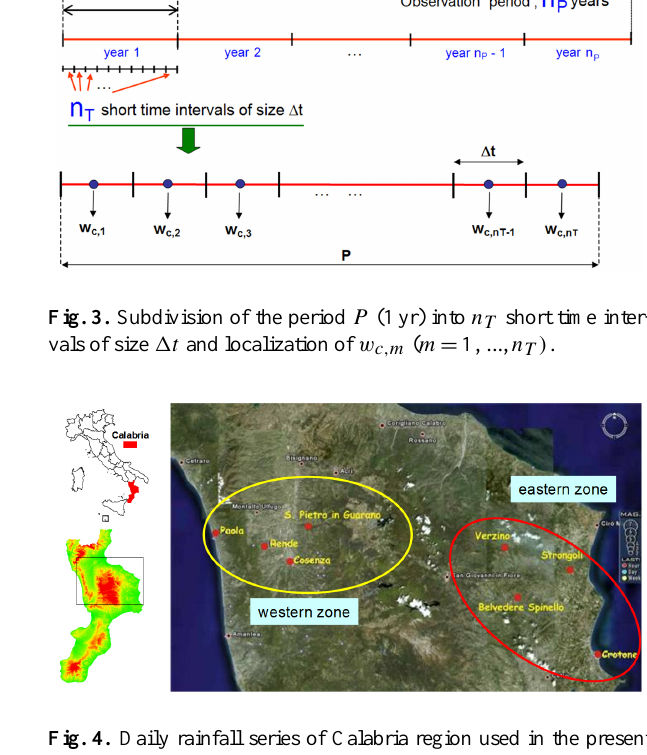
Fig. 4. Daily rainfall series of Calabria region used in the present